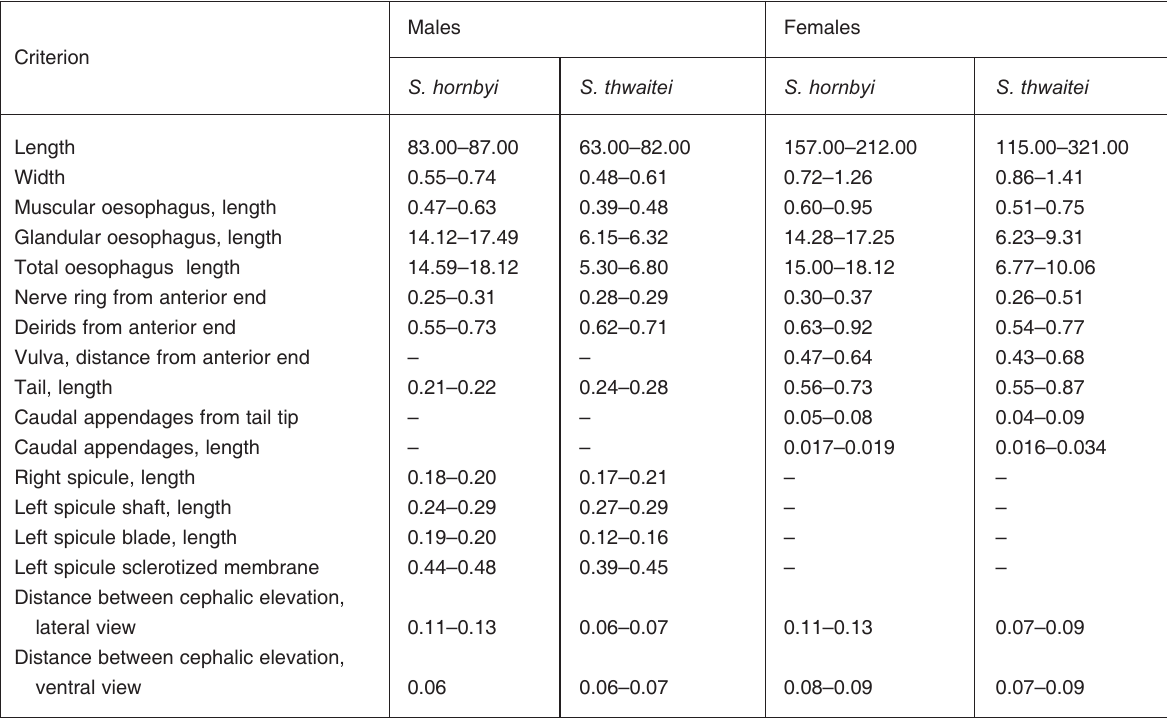
TABLE 2 Comparative measurements (in mm) of the South African Setaria hornbyi and of Setaria